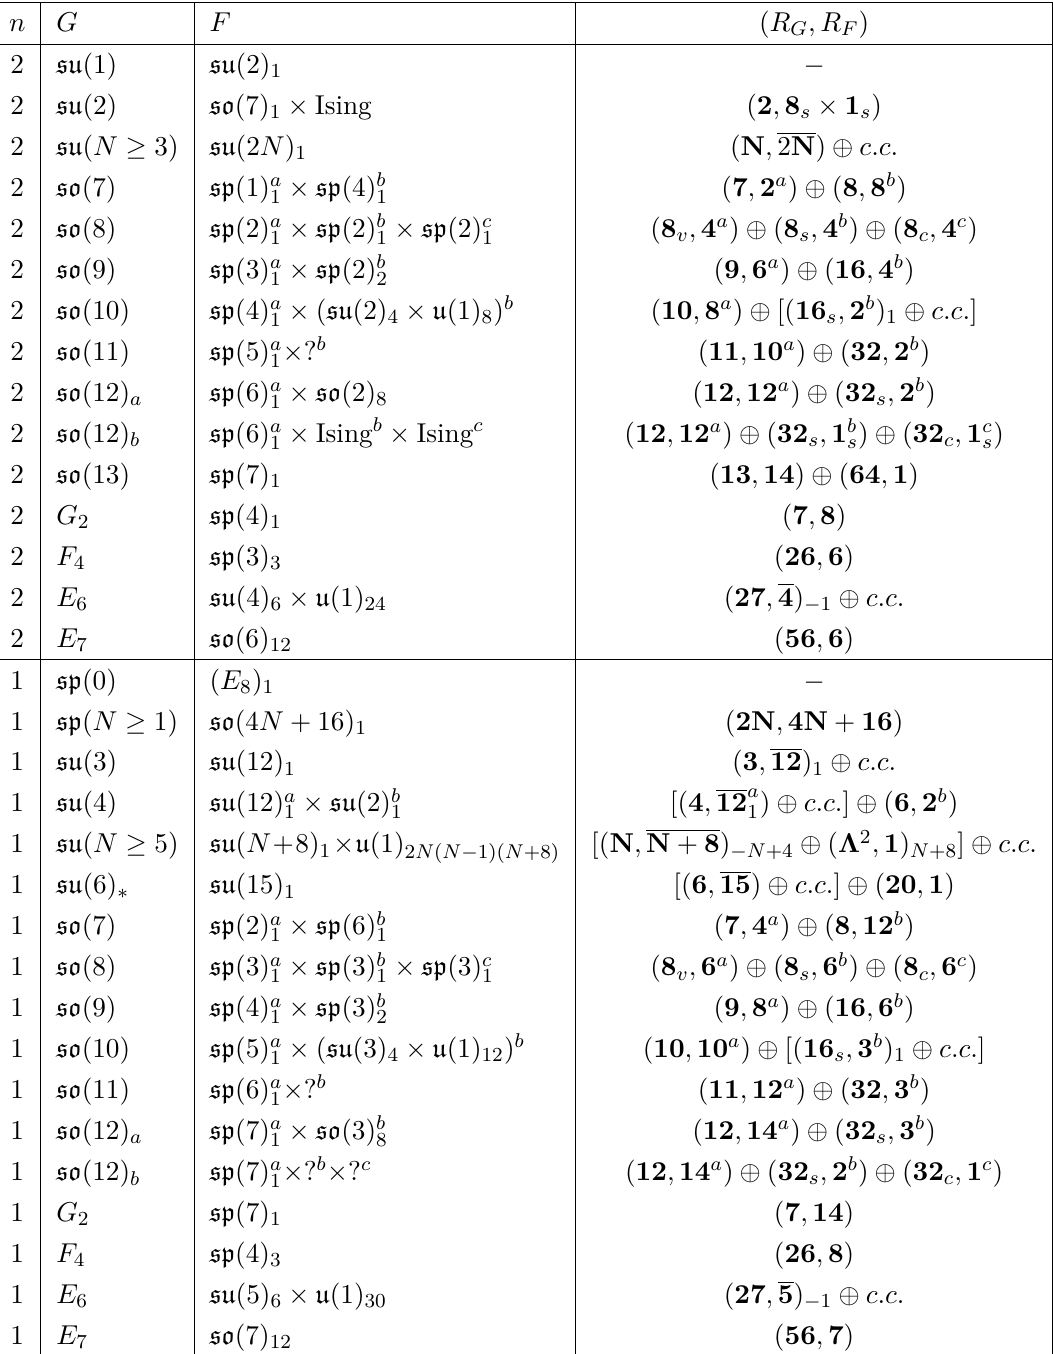
Table 3 . Gauge, flavor symmetries and charged matter contents of rank one 6d SCFTs with n = 1 , 2 [1]. Λ 2 is the rank-two anti-symmetric representation. ? means the flavor symmetry predicted by field theoretic considerations cannot be realised consistently on the worldsheet of BPS strings